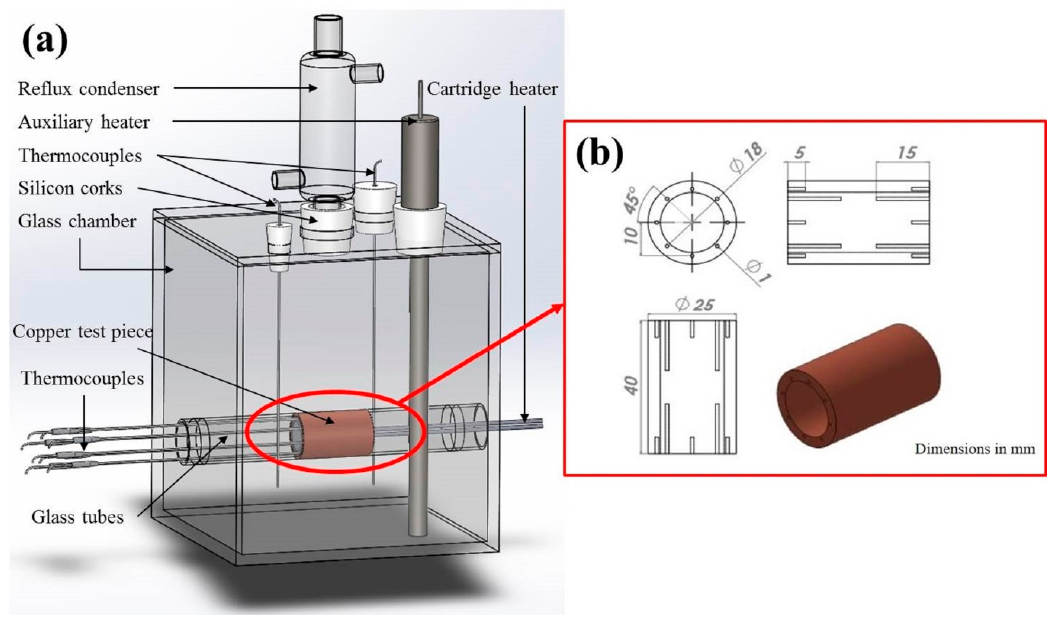
Figure 1. ( a ) Assembled view of the test section and ( b ) dimensional details of the copper test